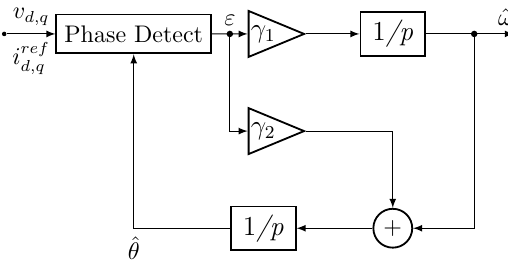
Figure 2. Flowchart of the PLL-type